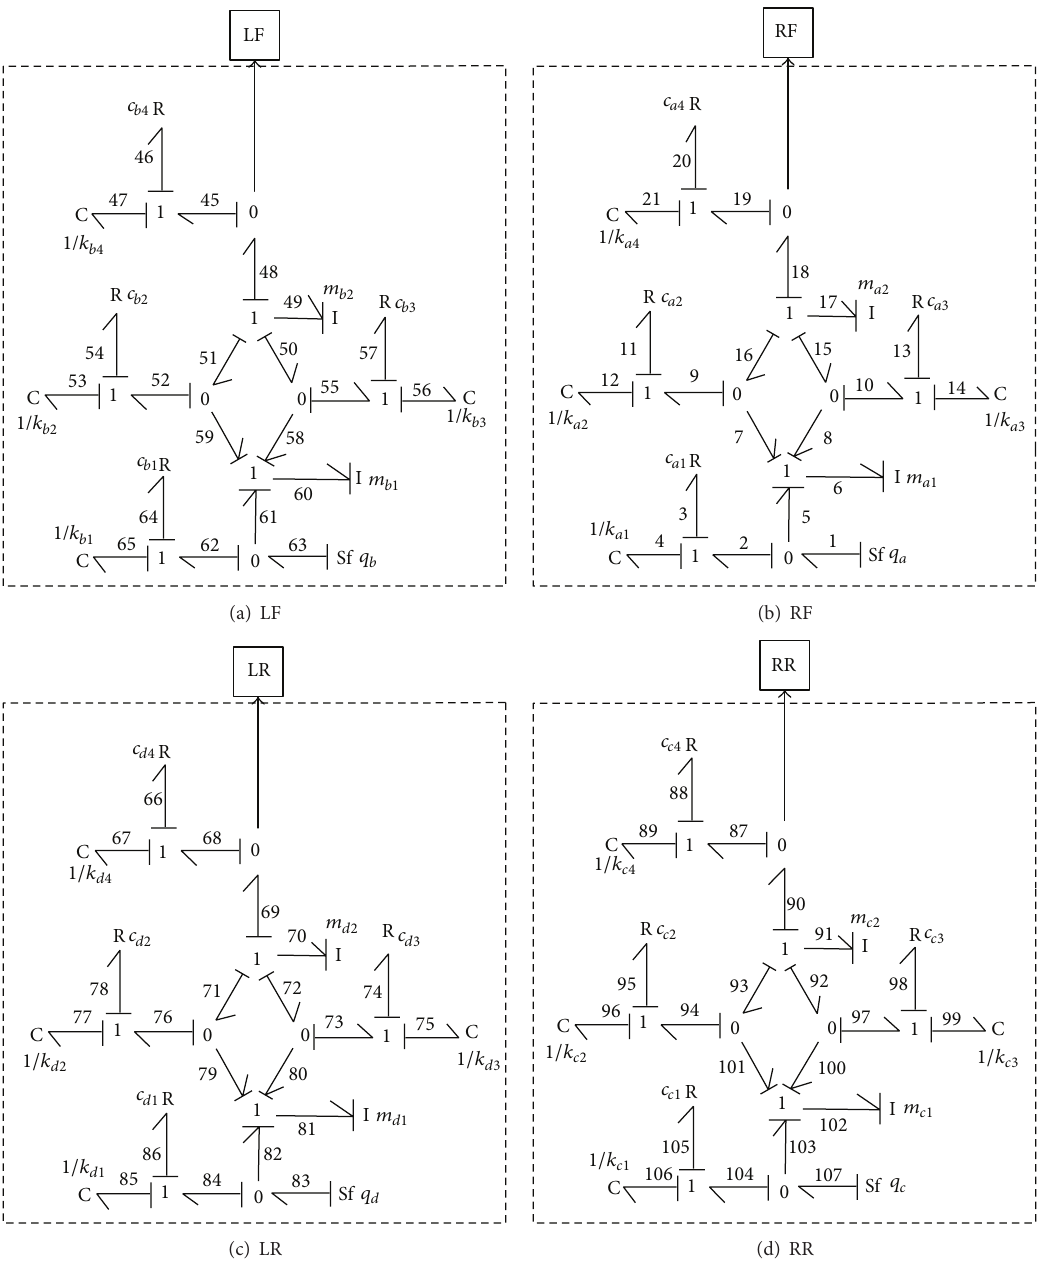
Figure 3: BG model of the four quarter car suspension